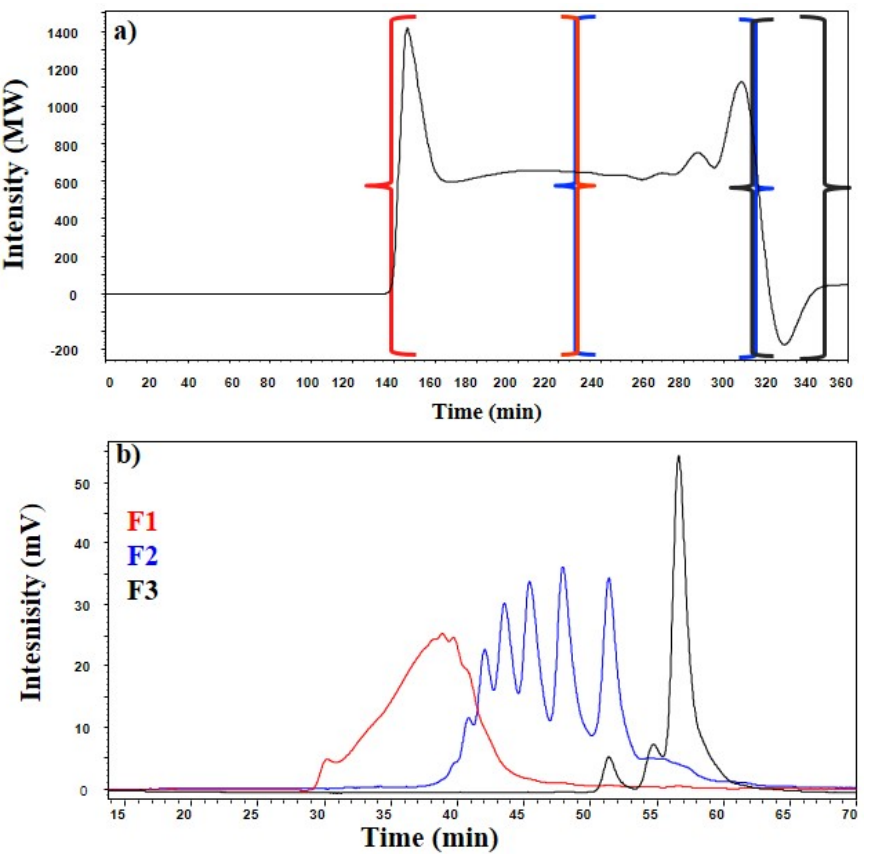
Figure 2. Profile of elution of prehydrolyzate from steam-exploded barley straw ( a ) chromatogram obtained by HPSEC Bio-Gel P2, ( b ) distribution of XOS analysed in. F1, F2 and F3 fractions. Fraction F1 contains the compounds whose molecular weights are >1000 Da. Fraction F2 includes compounds in the range of 300 to 1000 Da and fraction F3 contains compounds with molecular weights below 300 Da, monosaccharides making up the majority of the compounds in this fraction.